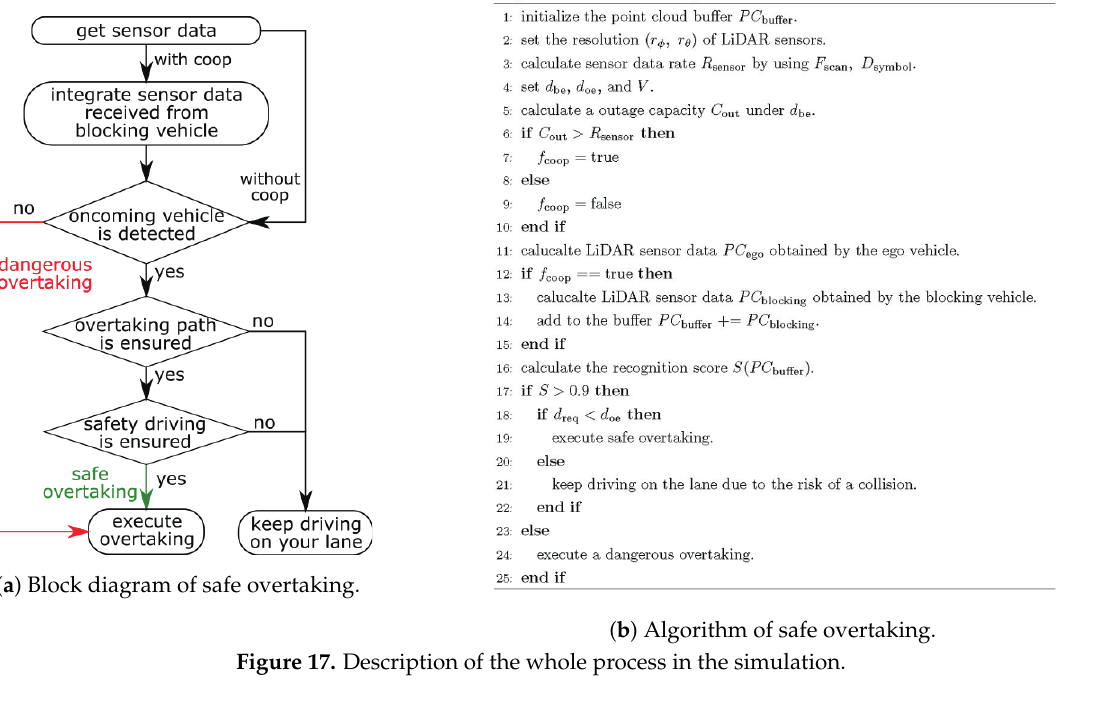
lines show the realized 0.01% outage data rate for each d be at 5, 30, and 60 GHz. Figure 21 shows the result of d be = 10 m using non-linear spacing LiDAR